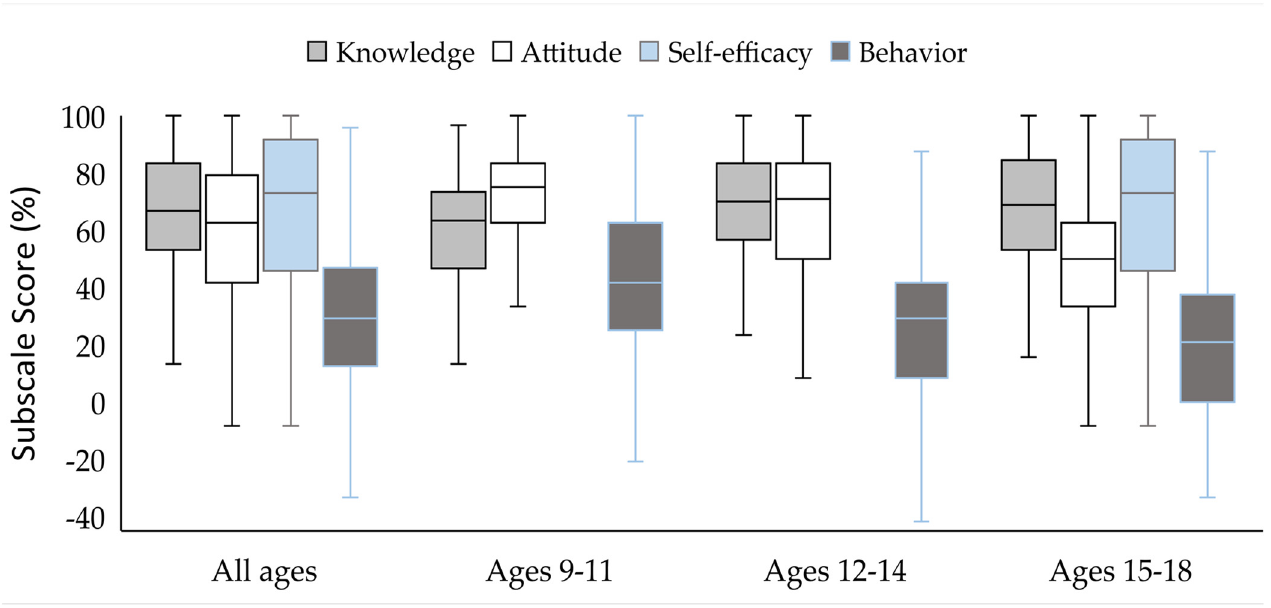
Figure 1. Subscale Scores by Age (Years). Bars represent the median, lower, and upper quartile subscales’ percentage scores within different age groups. Whiskers represent the minimum and maximum subscale score. n = 438. Table 4. Correlations of Participants’ Subscales by Age